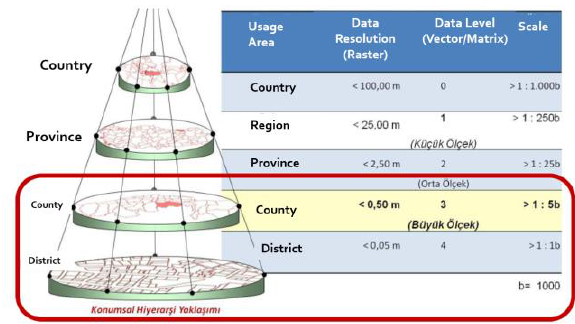
Figure 2. TRGIS spatial hierarchy approach (Aydinoglu,